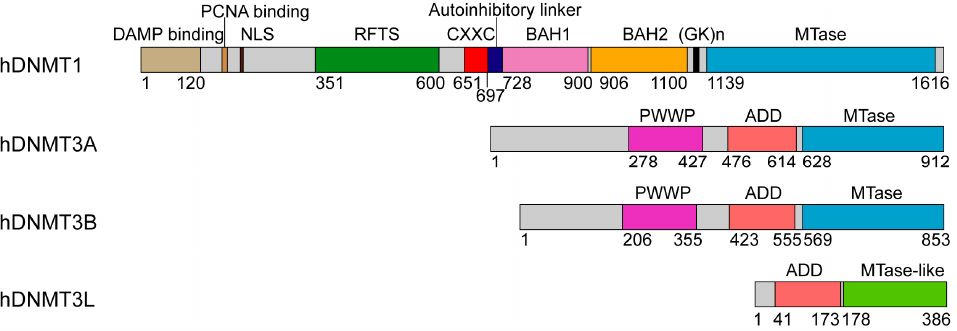
Figure 1. Domain architectures of human DNA methyltransferases: DNMT1, DNMT3A and DNMT3B, and regulator DNMT3L, with individual domains marked by residue numbers.